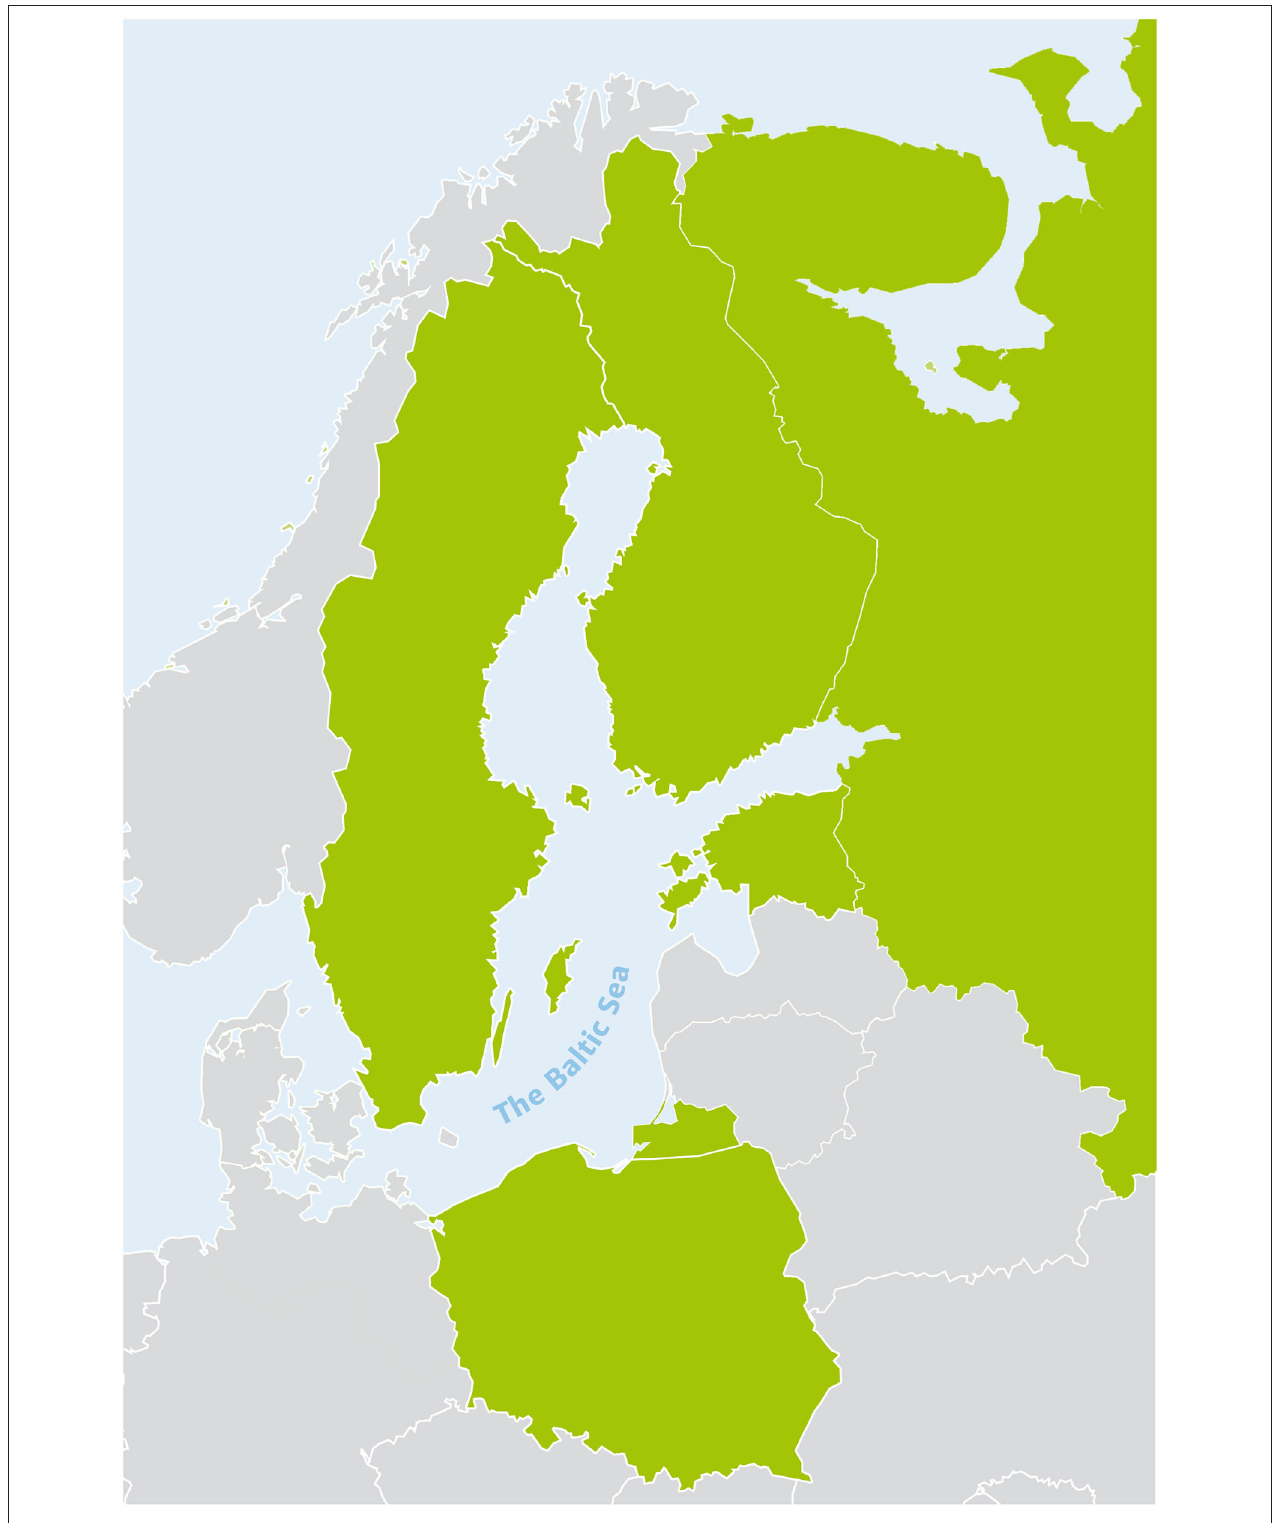
FIGURE 1 | Map of the study